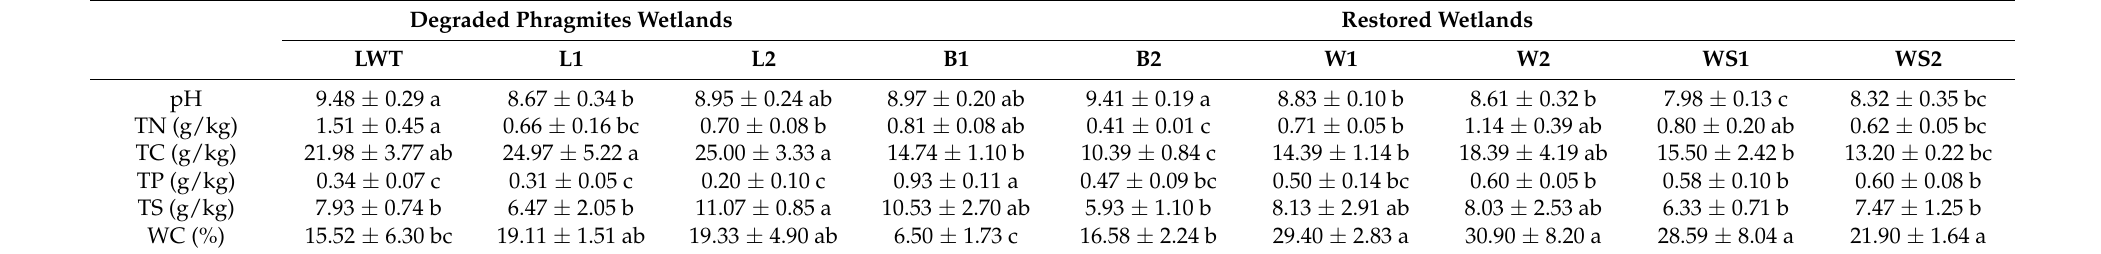
- Different letters in the table indicate statistical differences at p < 0.05, calculated by one-way ANOVA. Table 2. Soil characteristics (mean ± standard error) of the degraded and natural Carex wetlands.